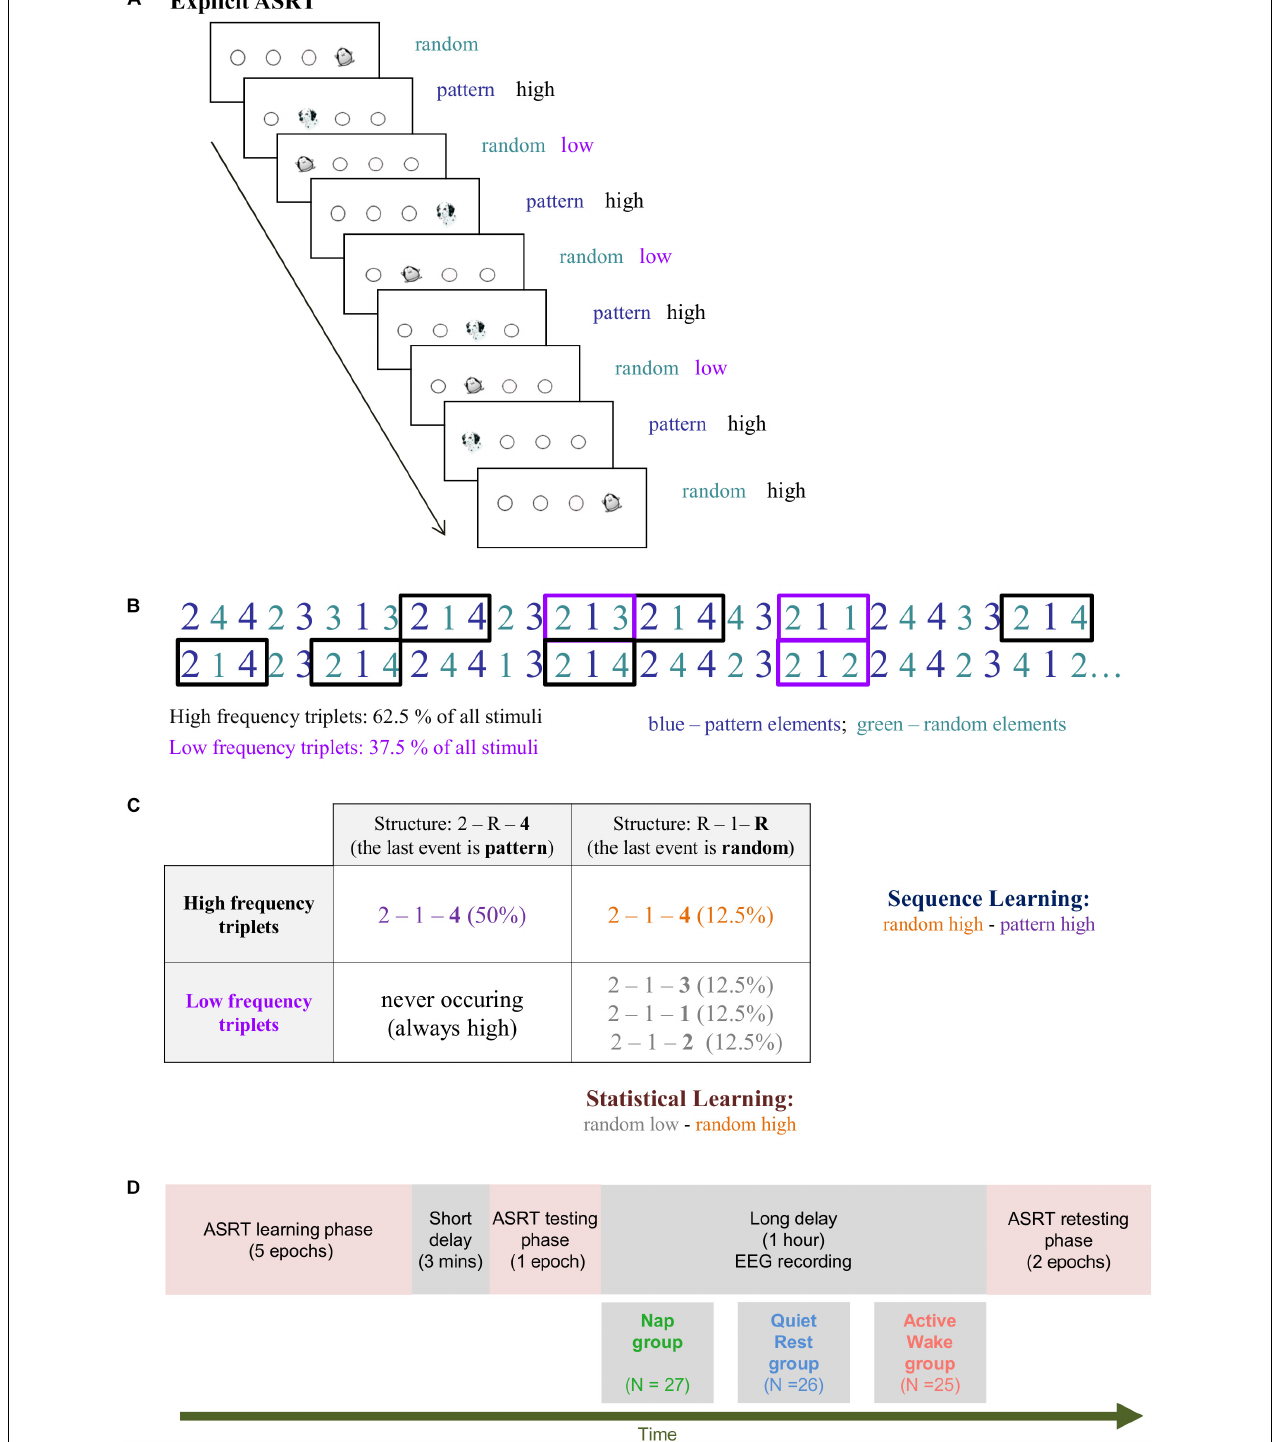
FIGURE 1 | The modified Alternating Serial Reaction Time (ASRT) task. (A) Pattern and random trials are presented in an alternating fashion. Pattern trials are marked with a picture of a dog, random ones with that of a penguin. Pattern trials always appear in a given location with high probability. Random trials include trials that appear in a given location with high probability and trials that appear in a given location with low probability. (B) As the ASRT task contains an alternating